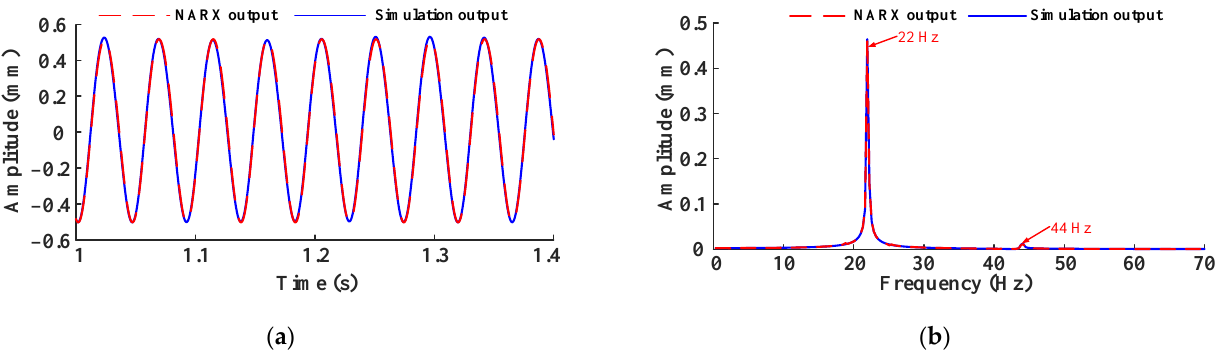
Figure 9. Response of the disk in x direction ( ω = 138.2 rad/s) ( a ) time-domain; ( b ) frequency domain.